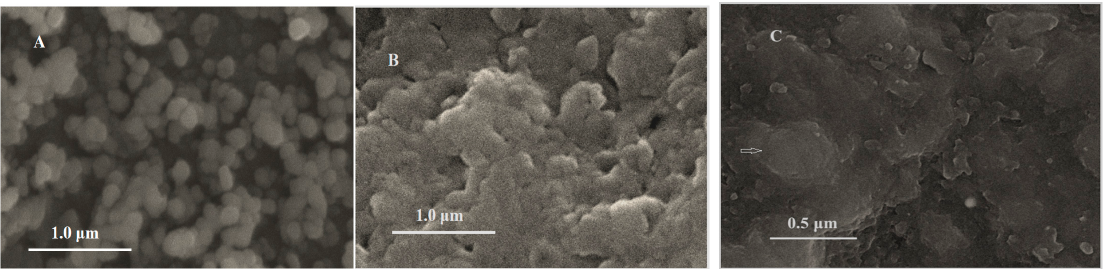
Figure 2. Scanning electron microscopy (SEM) images of ( A ) Fe 3 O 4 nanoparticles; ( B ) MIPs/Fe 3 O 4 ; and ( C ) high resolution of MIPs/Fe 3 O 4 .